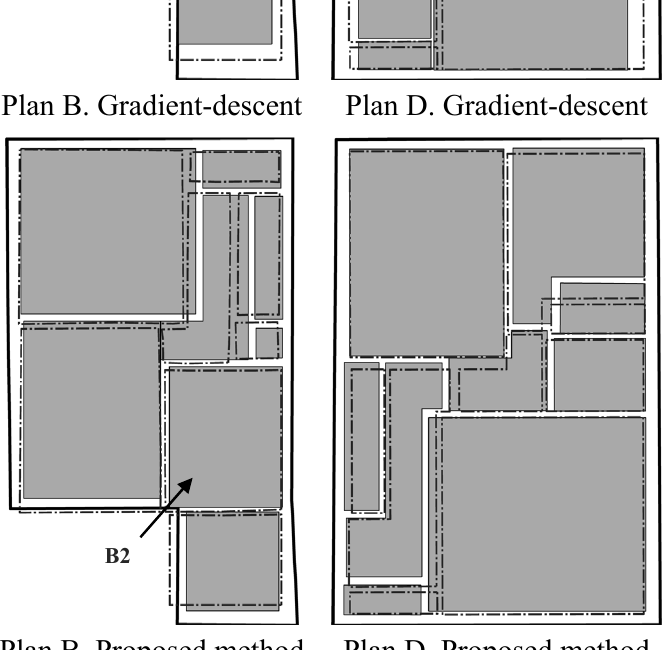
Figure 6. Input plans, gradient-descent and proposed method estimation results for plans B ( left ) and D ( right ). Plan measurements (solid grey), ground-truth (dashed lines). See Section 8.3 regarding B2 annotation.